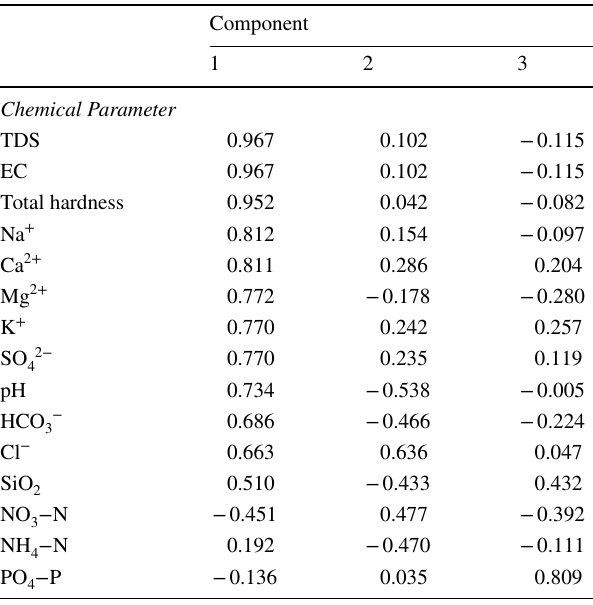
Table 3 Component matrix of the main physico-chemical